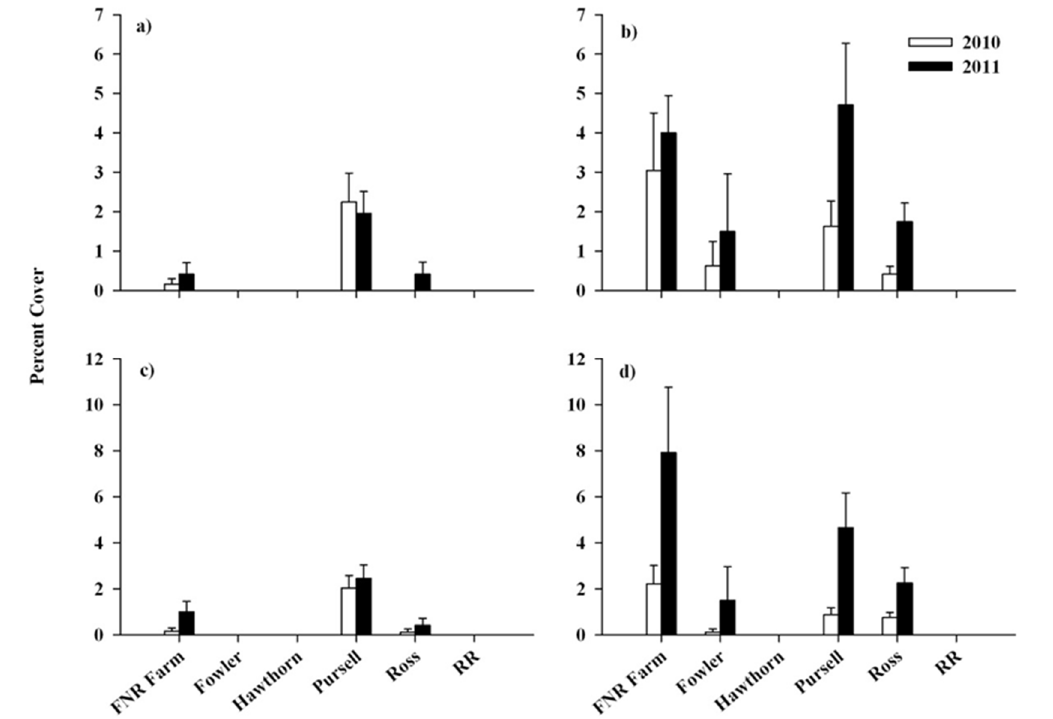
Figure 7. Mean percent cover (±1 SE) of Alliaria petiolata during the spring in reference areas ( a ) and removal areas ( b ); and during the summer in reference areas ( c ) and removal areas ( d ); in 2010 and 2011, at six mixed-hardwood forests in central